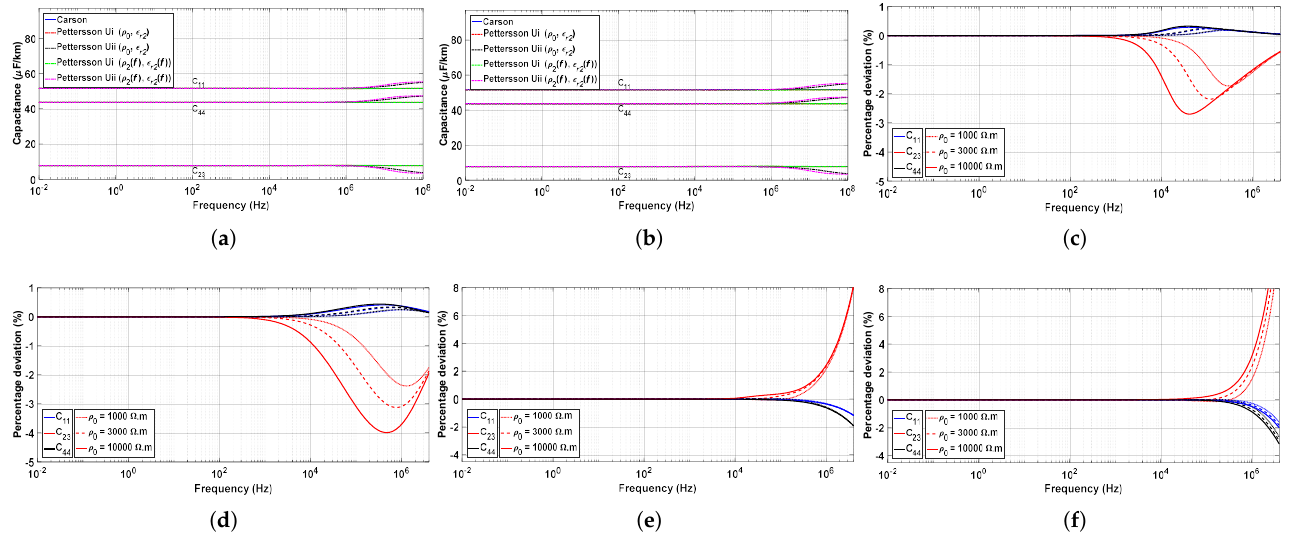
Figure 10. ( a ) Capacitance ( µ F/km) for the 1000 Ω .m; ( b ) Capacitance ( µ F/km) for the 10,000 Ω .m; ( c ) Percentage deviation between Carson’s and Pettersson’s formulation Ui; ( d ) Percentage deviation between Carson’s e Pettersson’s formulation Ui with frequency dependence; ( e ) Percentage deviation between Carson’s and Pettersson’s formulation Uii; ( f ) Percentage deviation between Carson’s and Pettersson’s formulation Uii with frequency dependence.